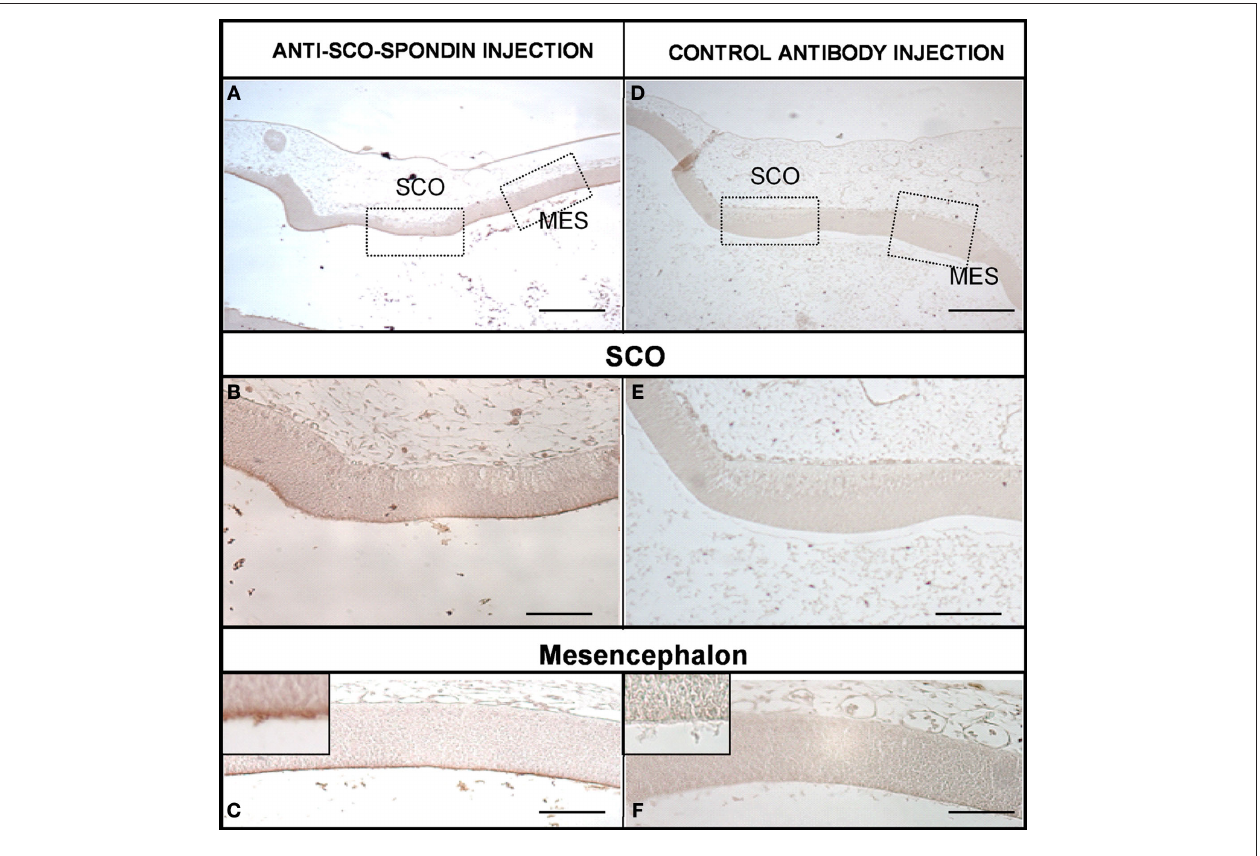
sacrified and immunostained using anti-rabbit IgG. Area boxed in (C) shows the presence of a thin immunoreactive line at the level of the neuroepithelial cells apical membrane. (D–F) Control experiment with an unrelated antibody. Scale bars represent 400 μ m in (A,D) ; 150 μ m in (B,E) ; 200 μ m in (C,F)